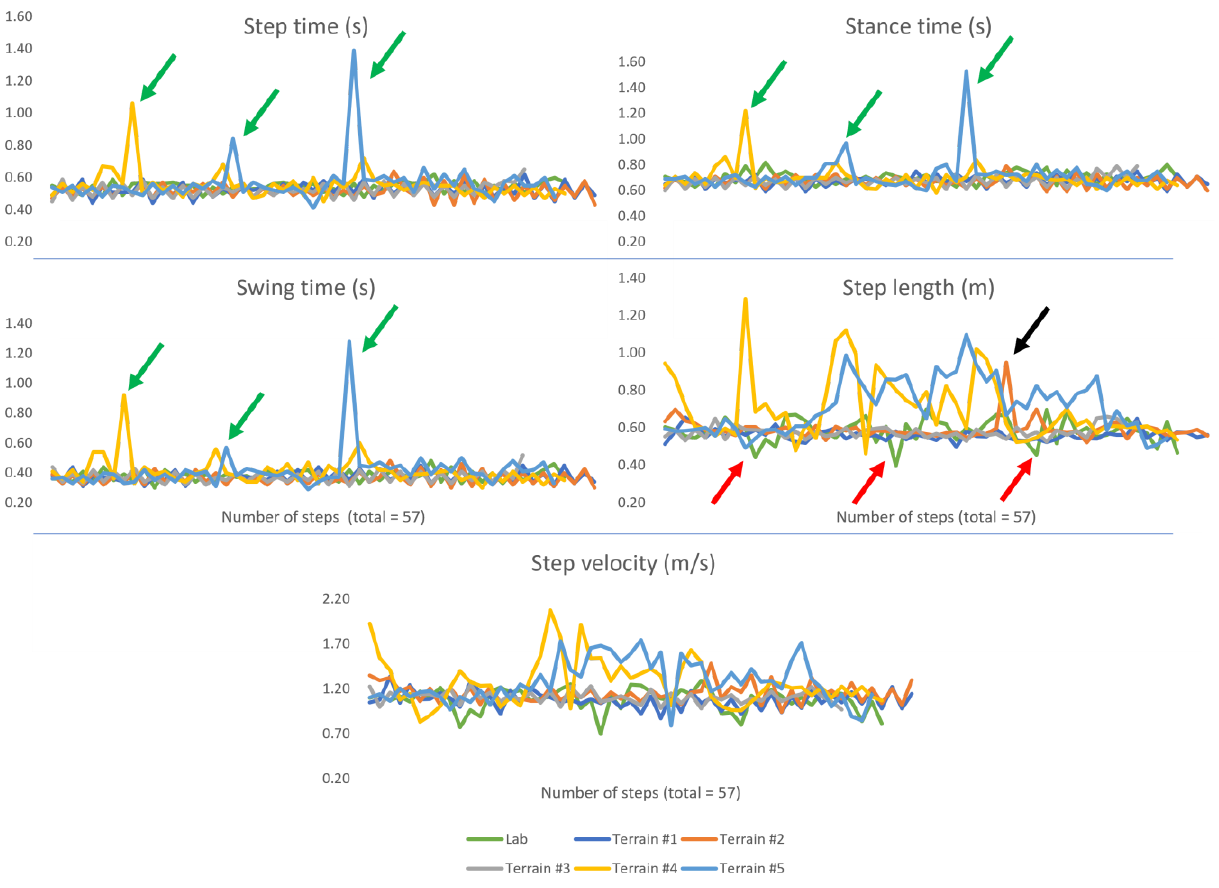
Figure 3. Spatio-temporal mobility-based gait characteristics from 30 s ( ≈ 57 steps) bouts of walking across the numerous terrain types. Here, we observed the greatest anomalies in the characteristics on terrains #4 (stair ascent, yellow) and #5 (stair descent, light blue). Typically, the remaining terrains present characteristics in what may appear to be normal fluctuations. Of note, the step length and step velocity in the lab bout (green) show some altered fluctuations and may be attributed to the protocol i.e., a walk in a looped (non-linear) circuit.